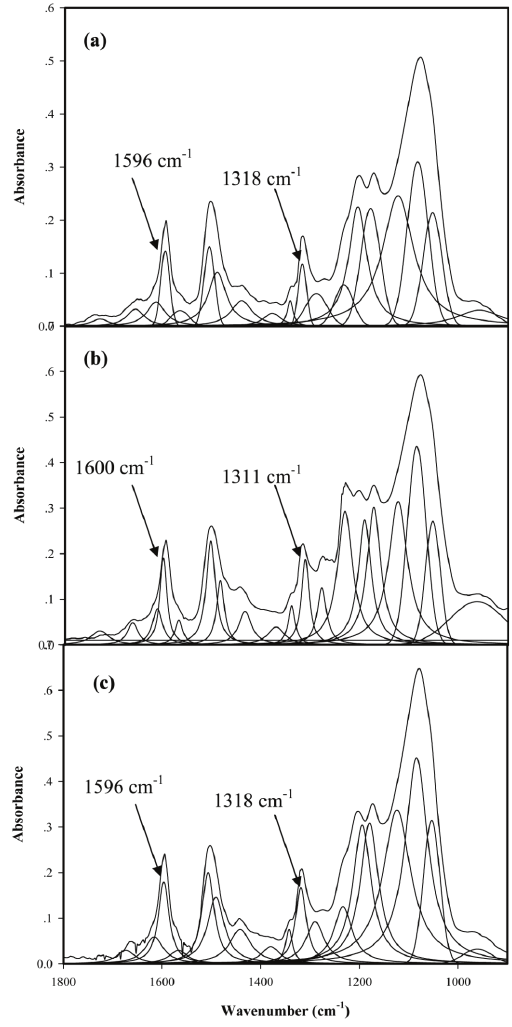
Figure 6. FT-IR second derivative of D-PDPA/30%Y_H + [80] composite when exposed to DCM.